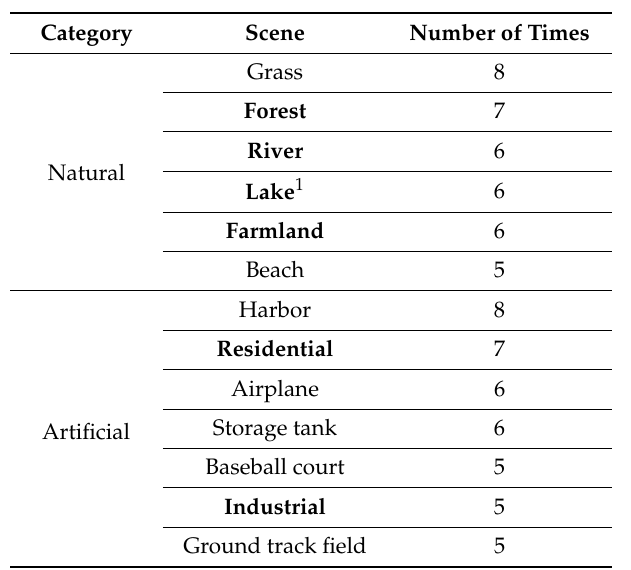
Table A1. Scenes mentioned more than 5 times in the investigations on remote sensing datasets. The bold cases were analyzed in the experimental